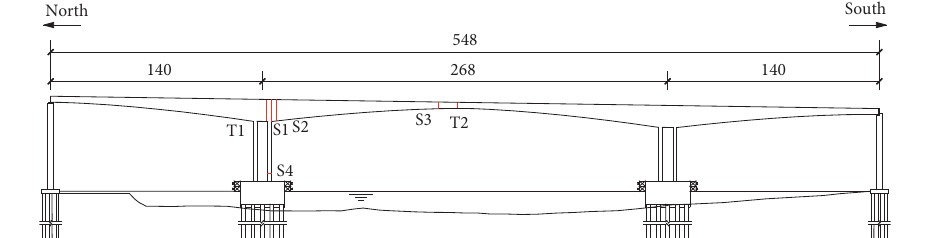
Figure 1: The auxiliary shipping channel bridge of the SuTong Bridge (unit: m).